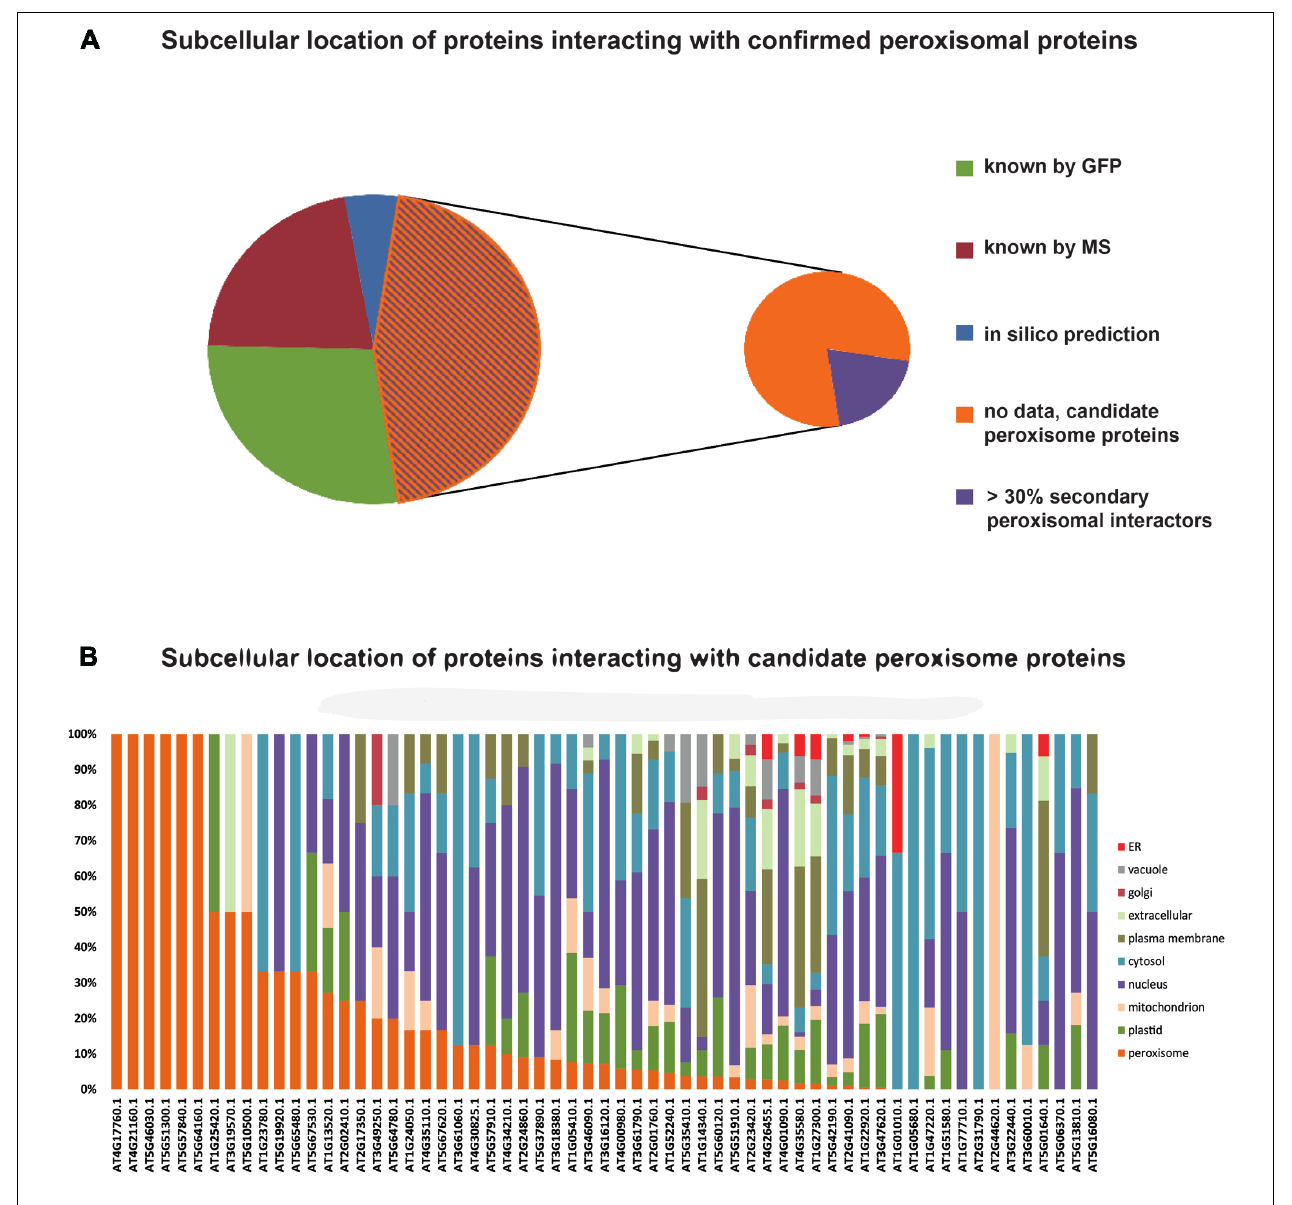
approach, their listing in Table 1 was done according to the following priorities: GFP > MS/MS > predictions. SUBA was then interrogated with the 60 candidate proteins to determine the localization of their interaction partners, as summarized in the SUBAcon (B) . Proteins are sorted by the percentage of peroxisomal interactors, regardless of the overall number of interacting proteins. For six proteins, the bait protein was the only interactor. For some proteins on the list of Kaur and Hu (2011) SUBAcon states a non-peroxisomal localization.Therefore, 13 proteins do not appear to have a single peroxisomal interaction partner although at least the bait protein is expected